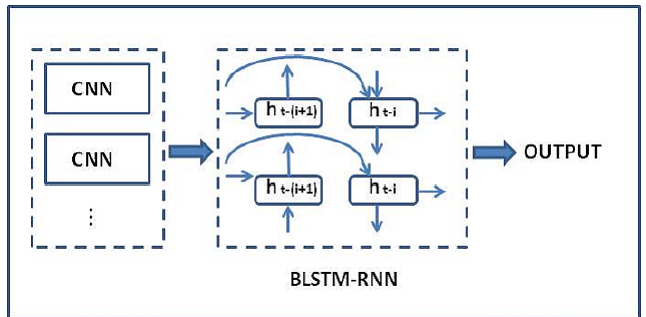
Figure 2. Topology of the CNN algorithm as input for the BLSTM-RNN algorithm, computing the hidden sequence h .